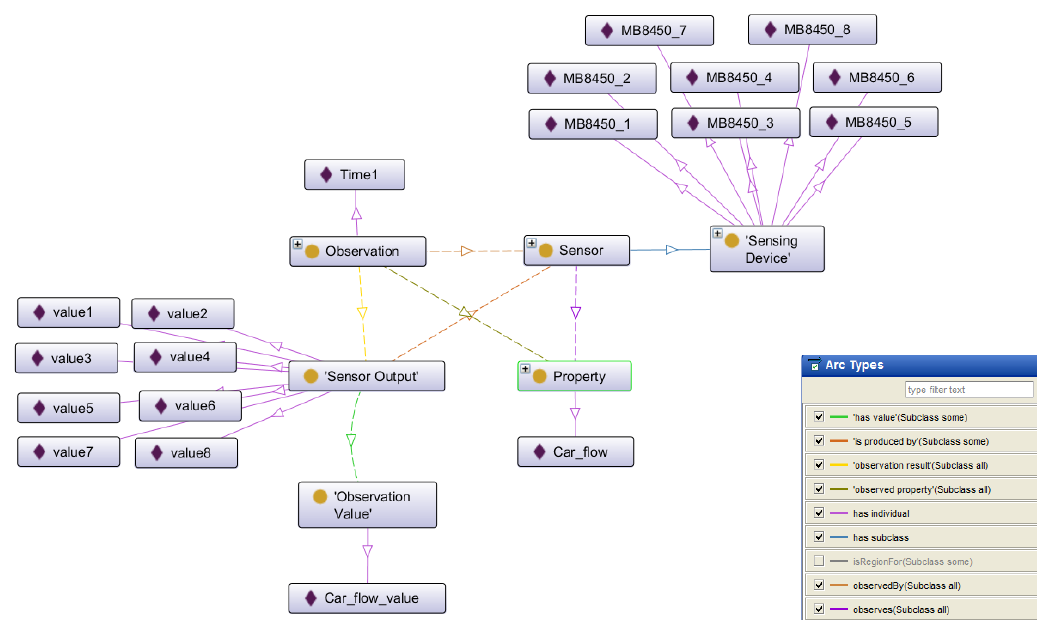
Figure 5. Instance of SSN ontology.